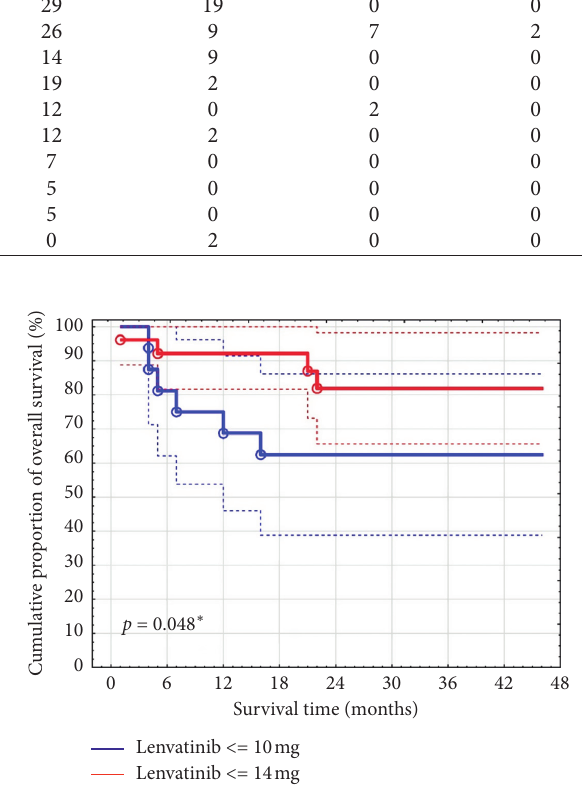
Figure 1: Overall survival with a daily dose of lenvatinib ≤ 10mg